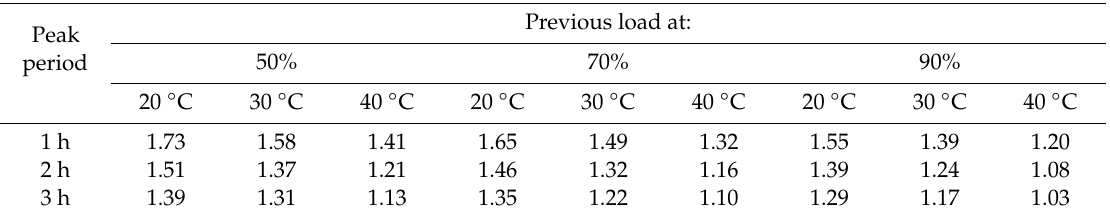
Table 6. Allowable peak overloads to select the capacity of oil-cooled transformers. Allowable Peak Overloads to Select the Capacity of the Oil-Cooled Transformers, Equivalent Load in Percentage of the